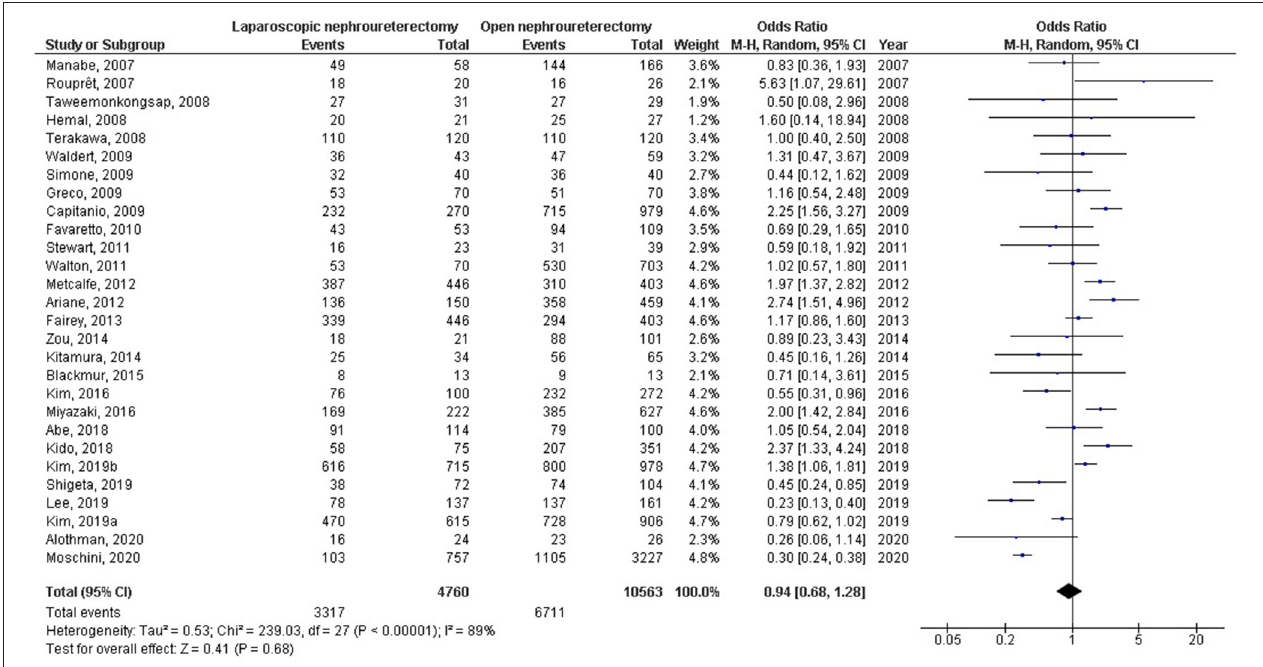
FIGURE 1 | Schematic diagram of the study procedure.